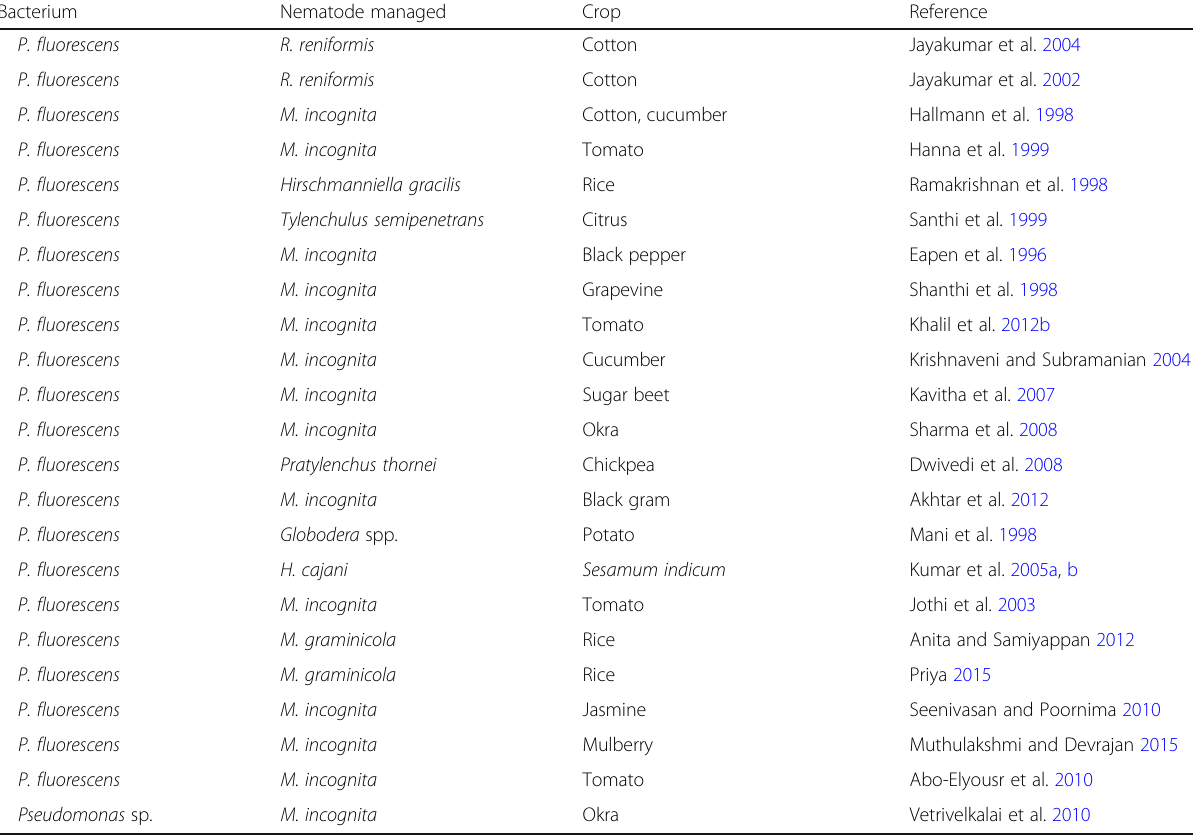
Table 6 List of bacterial biocontrol agents against phytonematodes infesting agricultural crops (Continued)